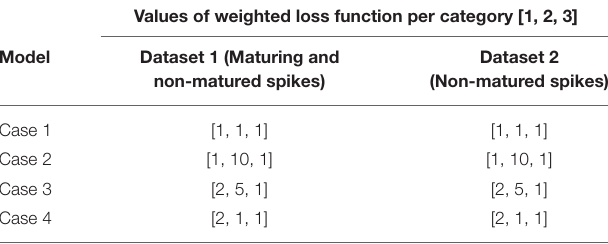
TABLE 2 | Two datasets trained the CNN model with four cases of the study through different weights in loss functions for each category. Values of weighted loss function per category [1, 2, 3]